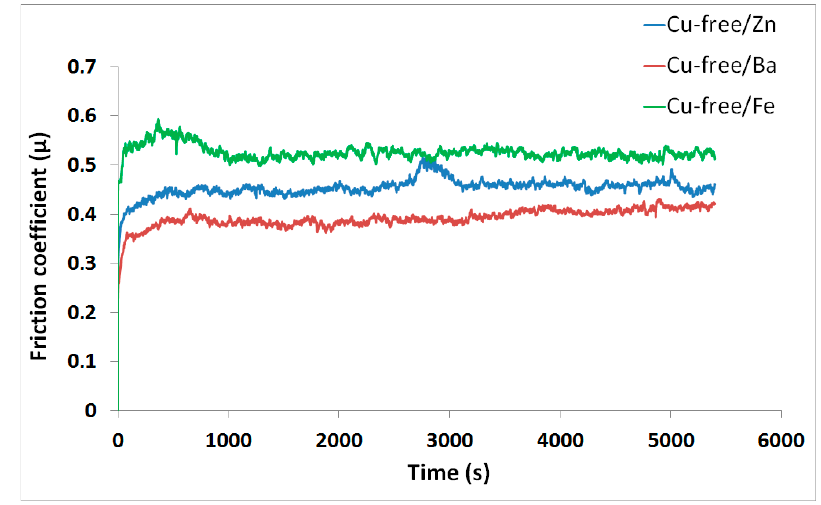
Figure 2. Friction coefficient evolution obtained from representative PoD tests conducted on the three friction materials. Table 2. Average values of friction coe ffi cient ( µ ) at steady-state and experimental specific wear coe ffi cients (K a